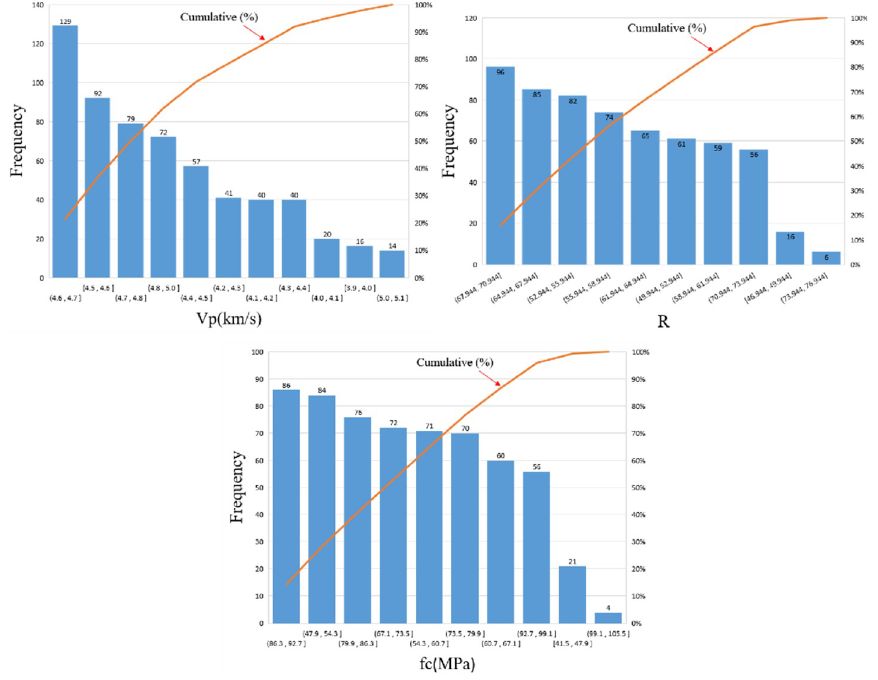
Fig 14. Frequency histograms of the